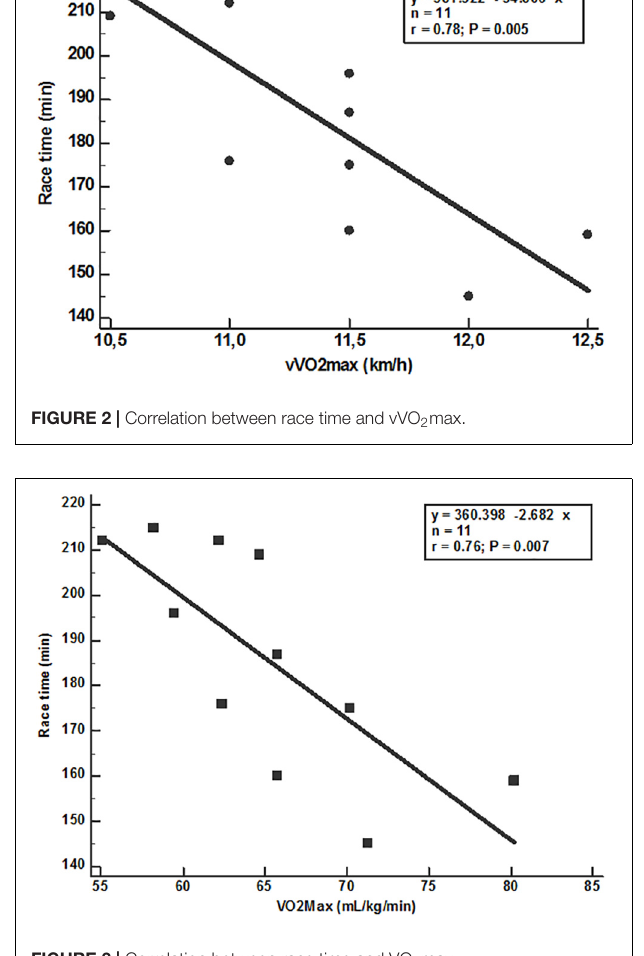
FIGURE 3 | Correlation between race time and VO 2 max.